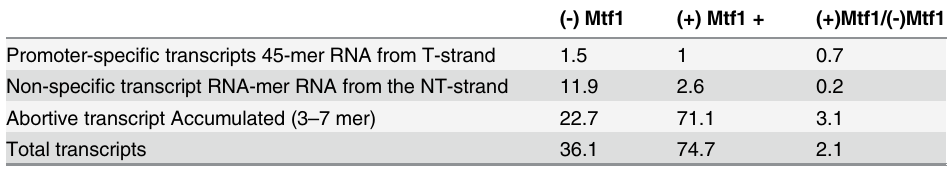
Table 2. Selective inhibitory effect of Mtf1 on holoenzyme